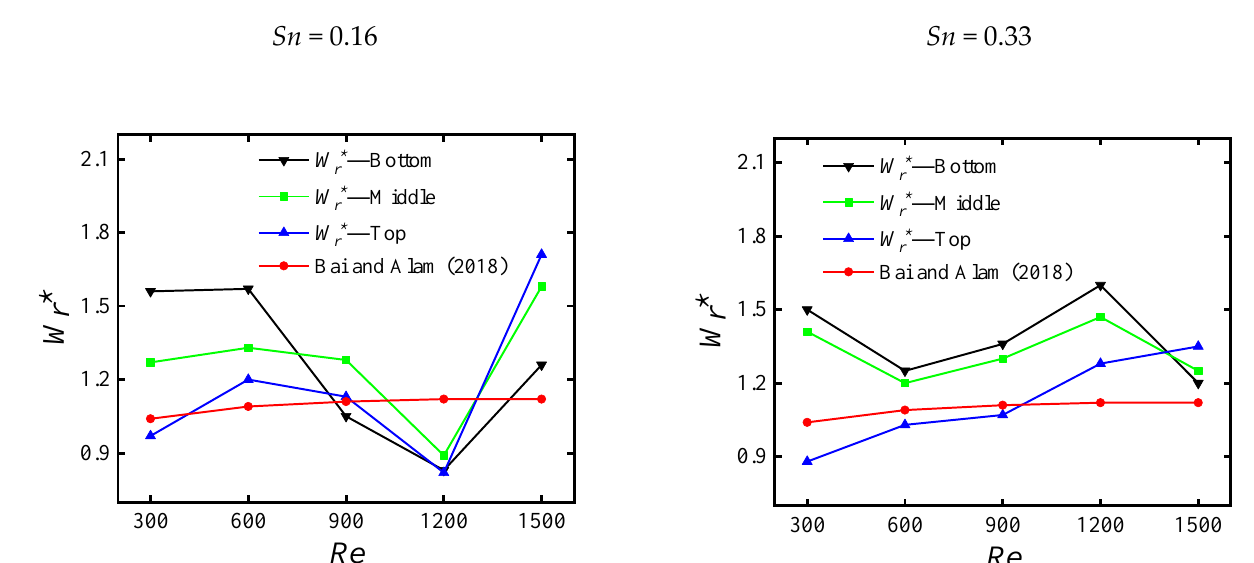
Figure 11. Dependence of the non-dimensional recirculation width ( W ∗ r ) on the Reynolds number. The overall trends of the non-dimensional recirculation width ( W ∗ ) are divided into r two regimes, namely TrW 2 and TrSL 1 . For Sn = 0.16 in the TrW 2 regime, W ∗ increases r alongside the Reynolds number, and a value around 1.57 is attained in the regimes where flow transfers from TrW 2 to TrSL 1 . W ∗ drops in the TrSL 1 regime where the minimum r value is 0.83. However, in the post TrSL 1 regime, W ∗ rises progressively to a maximum r of 1.71 on the top section. This is mainly because the shear layers have been disturbed. For Sn = 0.33 in the TrW 2 regime, the value of W ∗ decreases in the middle and bottom r sections. However, it increases in the top section from the TrW 2 to the TrSL 1 regime and its value, in general, is smaller than those in the middle and bottom sections. The minimum W ∗ , approximately 0.88, is obtained at Re = 300. Additionally, in the middle and r